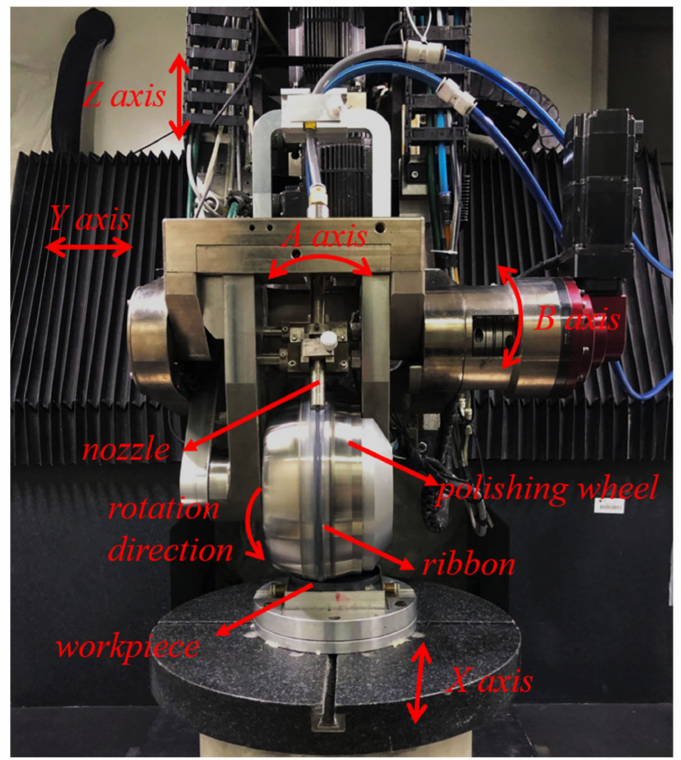
Figure 1. The self-developed MRF machine